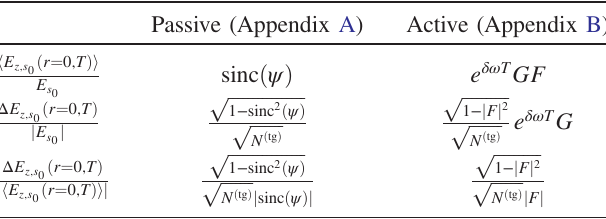
TABLE I. Averaged and standard deviation of the wake complex amplitude in passive and active media. Here, the initial phase-spread of the electrons at the resonance mode s 0 is 2 ψ ¼ ω Δ z= β c , where Δ z corresponding to initial length of 0 electrons locations. For the results regarding the passive medium it was assumed that the electrons are uniformly distributed. For the AM, the results are the same for both uniform and normal distributions but with different F